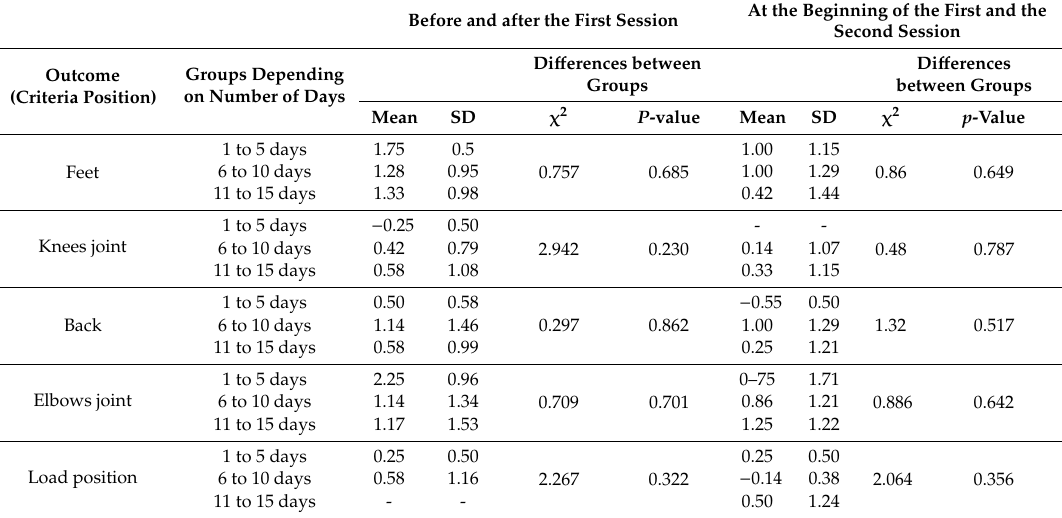
Table A2. Di ff erences in the score change of the frequency of recommended positions for criteria identified by the SsObserWork group according to the number of days the self-report questionnaire was completed.